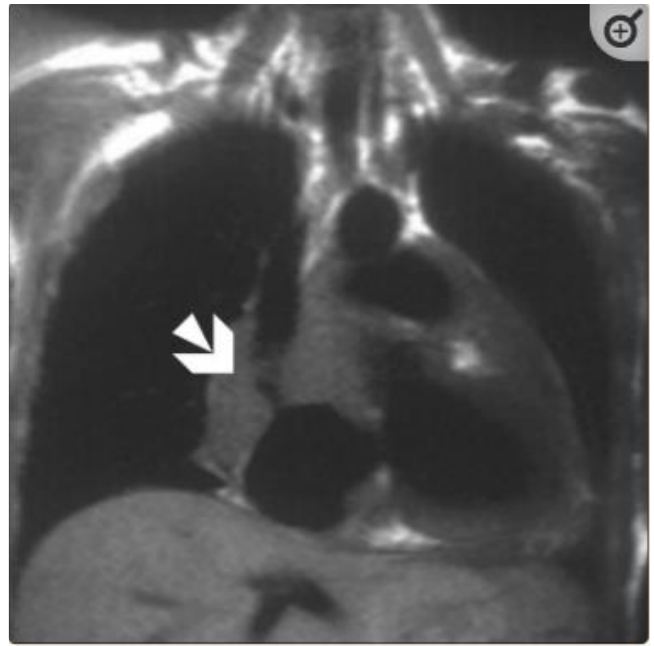
Figure 5. T2W dark-blood coronal MRI image shows diffuse myopericardial thickening. The thick- ening is hypointense on T2W images and is causing attenuation of the proximal SVC (arrow). The image was adapted from [53].